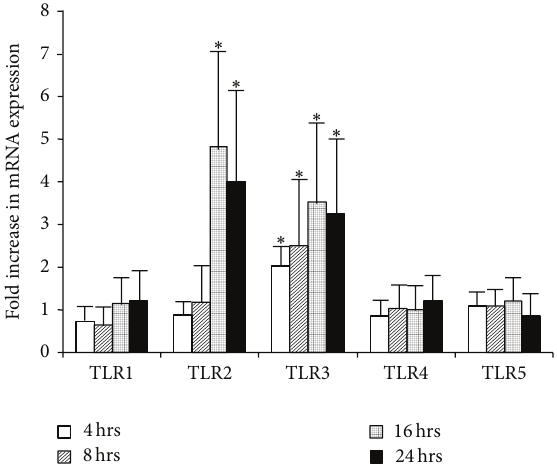
Figure 6: Hypoxia stimulated TLR mRNA expression in submerged primary conjunctival epithelial cells. Cells were cultured in 95% N 2 and 5% CO 2 at 37 ∘ C for indicated duration before being harvested for RNA extraction and qPCR. The experiment was repeated in 3 different batches of primary cells, and the averaged changes were shown. 𝑌 error bars represent the standard deviation of the averaged results.Asterisks( ∗ )denotesignificantdifferencewhencomparedto cells under normoxia condition.